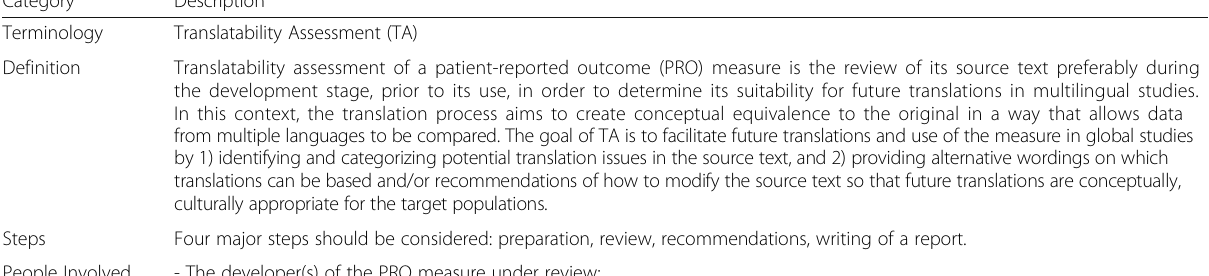
Table 3 Summary of Translatability Assessment (TA) Good Practices for patient-reported outcome (PRO)